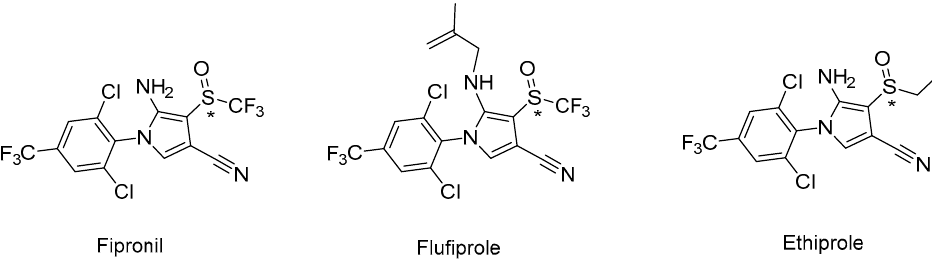
Figure 5. Chemical structures of chiral phenylpyrazoles pesticides (Fipronil, Flufiprole, Ethiprole) with the asymmetry on the sulfur atom (* denotes the chiral centers).